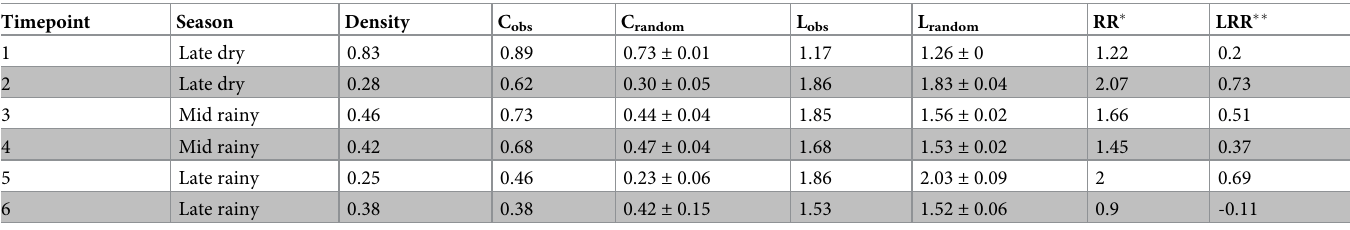
C = clustering coefficient, L = average path length, RR (response ratio) = C obs /C random, LRR (log response ration) = ln(C obs /C random